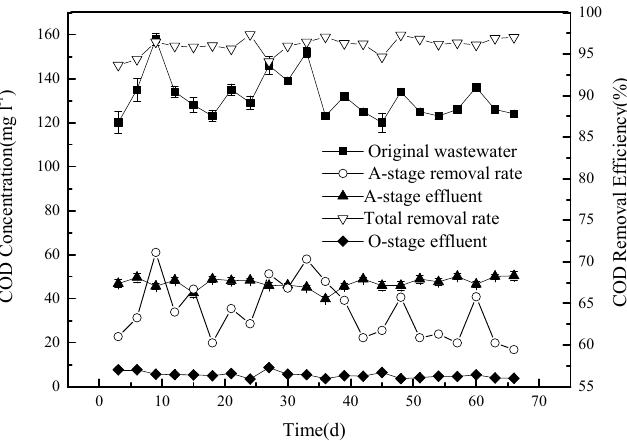
Figure 3. The concentration of COD (black symbols, left axis) at various stages of the system, and the removal efficiency in % of COD (open symbols, right axis).